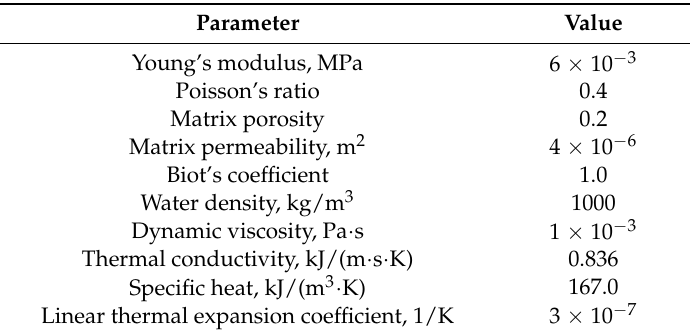
Figure 3. Comparison of simulation results with the analytical solution. Table 1. Input parameters used for validation.